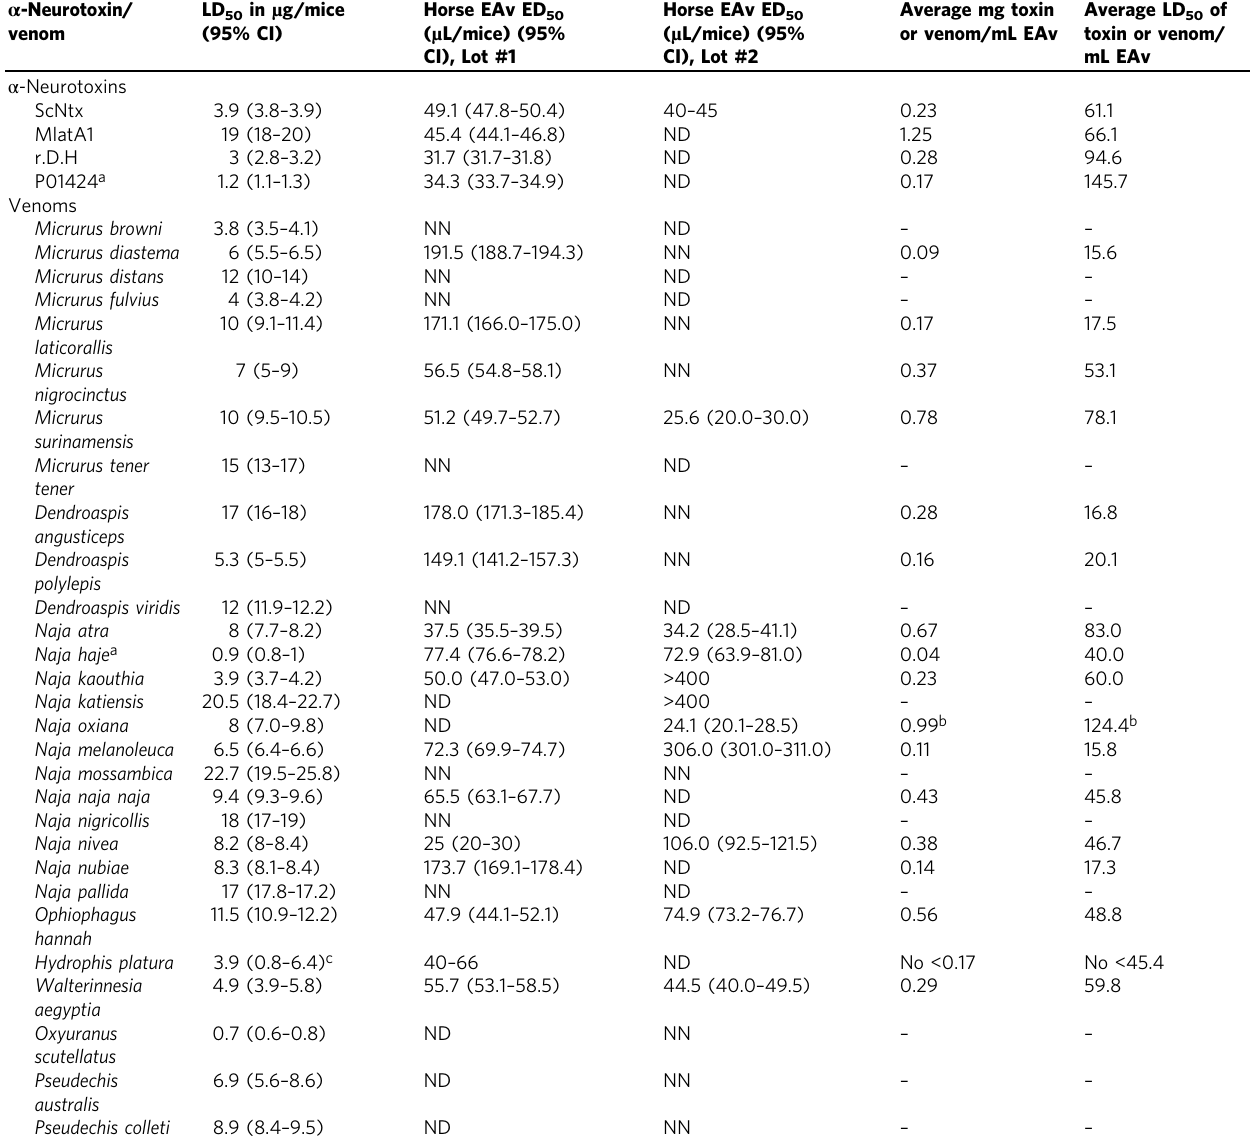
Table 1 Median LD 50 and ED 50 values of α -neurotoxins or elapid venoms, as well as median values of antivenom (EAv) α